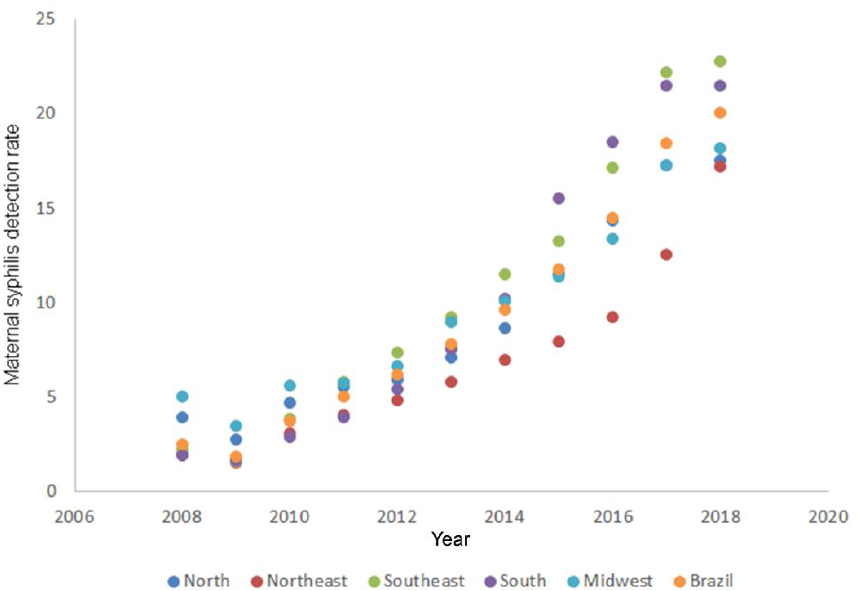
Figure 1. Time series of gestational syphilis detection rate in Brail and all Brazilian regions, according to the Joinpoint model. Brazil, 2008 to 2018. Indicates that the annual percent change is significant.